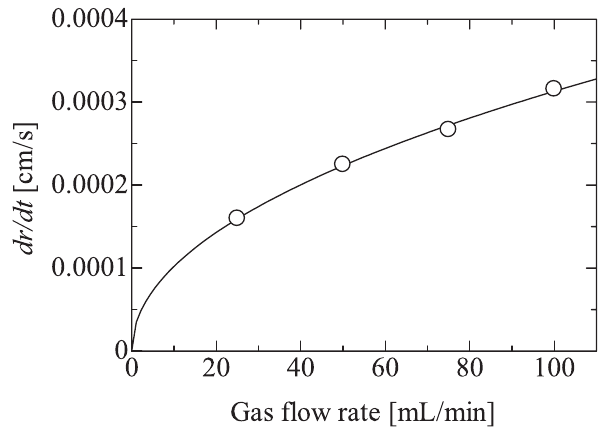
Fig. 15: Relation between gas flow rate and dissolution rate when 3.5 g of sintered lime (s-Lime) dissolved into 100 g of FeO-CaO-SiO slag.